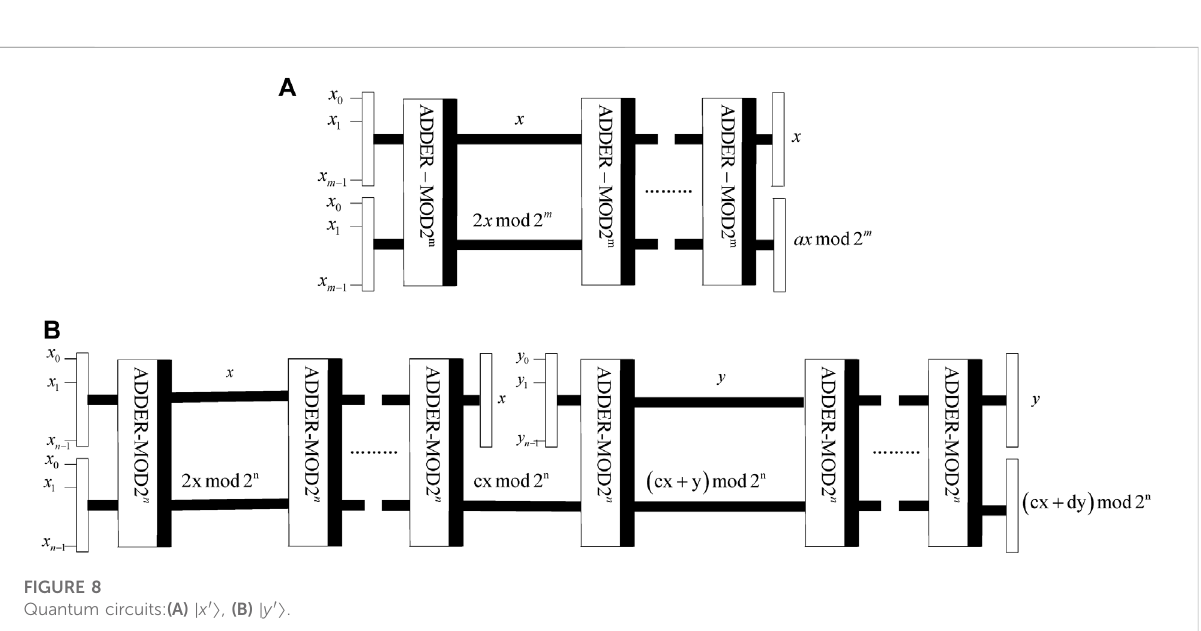
scale triangular map which is applied on the n − w 1 and m − w 1 qubits and the scrambled block image acquired.